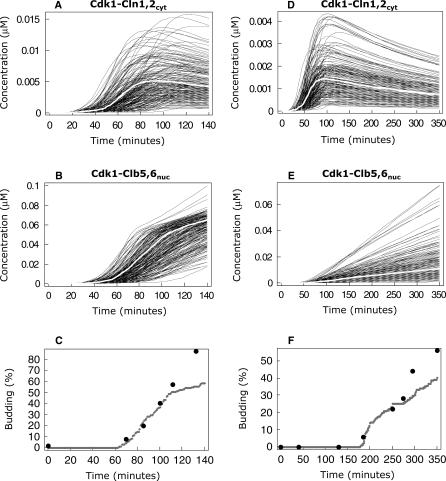
Population Effects on Budding Onset in Yeast Populations Grown in Glucose or in EthanolTo mimic differences in individual cells in a population, all parameter values are drawn from a normal distribution having the values of the ODE model as mean value.(A,D) A series of individual realizations is shown for Cdk1-Cln1,2cyt. The white curves represent the realizations for the original parameters.(B,E) Individual realizations for Cdk1-Clb5,6nuc.(C,F) Cumulative number (in %) of budded cells as a function of simulation time determined from the realizations presented in (A) and (D) (see Materials and Methods for details on calculation on budding time). Black dots refer to the experimental budding points determined for elutriated wild-type cells.